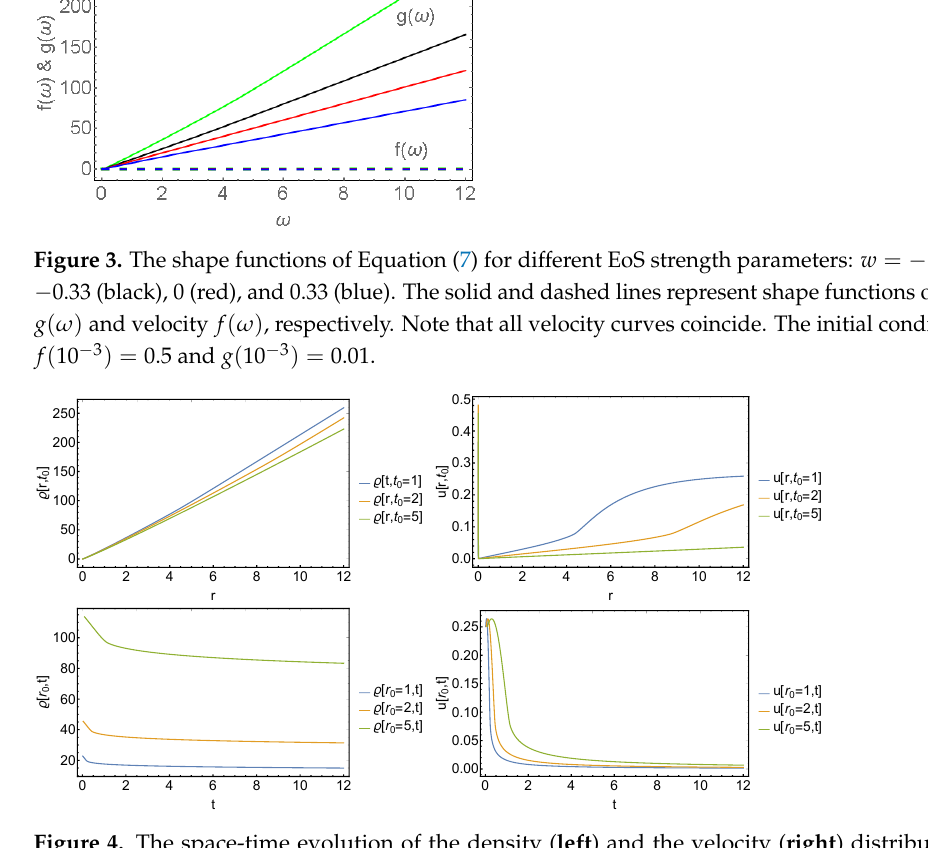
Figure 4. The space-time evolution of the density ( left ) and the velocity ( right ) distributions for the case, w = − 1. Curves are for the radial ( top panels ) and time ( bottom panels ) dependence at different fixed time- and space points. The initial conditions are f ( 10 − 3 ) = 0.5 and g ( 10 − 3 ) =